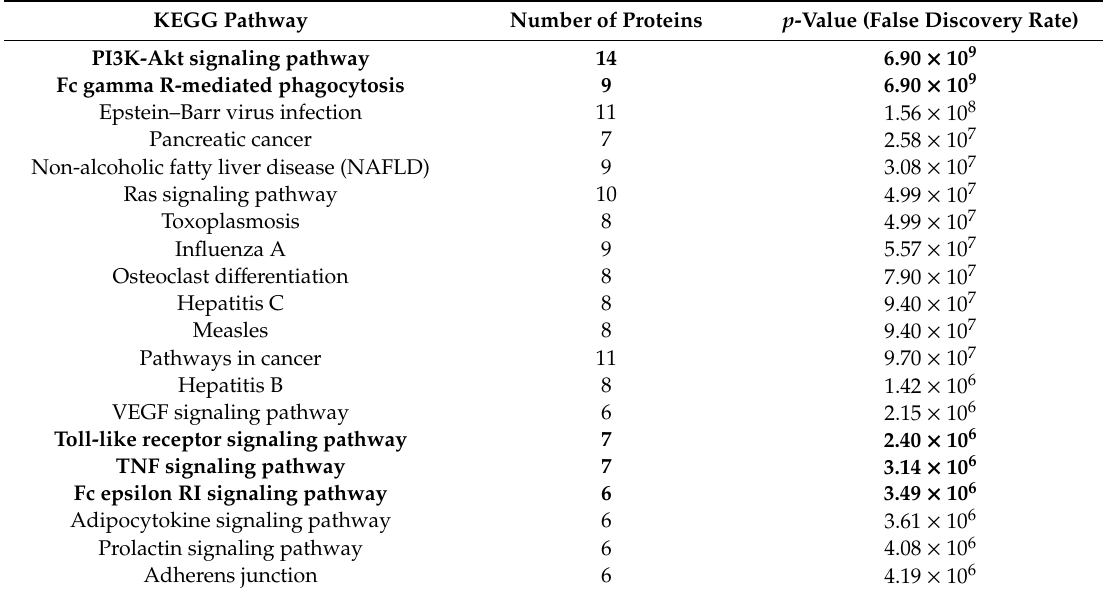
Table 7. Top 20 KEGG pathways enriched from unique peptides in the postbiotic jejunum (compared to C. perfringens challenge and postbiotic plus C. perfringens